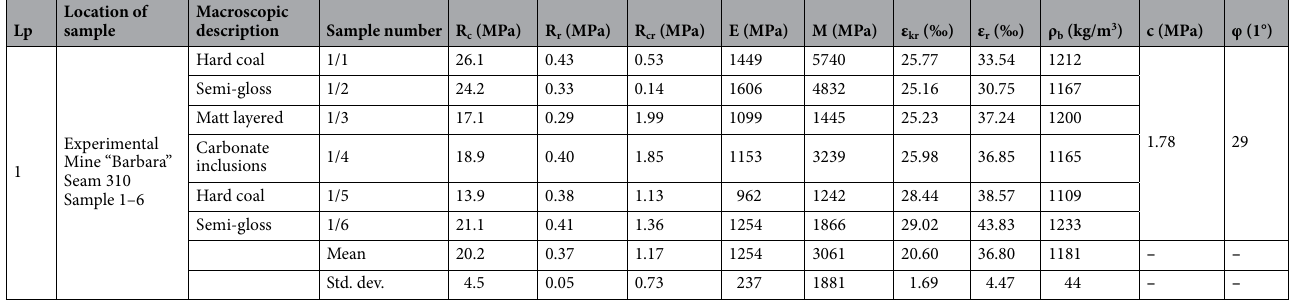
Table 1. Results of measurements of physical and mechanical parameters of hard coal samples from Experimental Mine “Barbara” (seam 310, 6 samples).